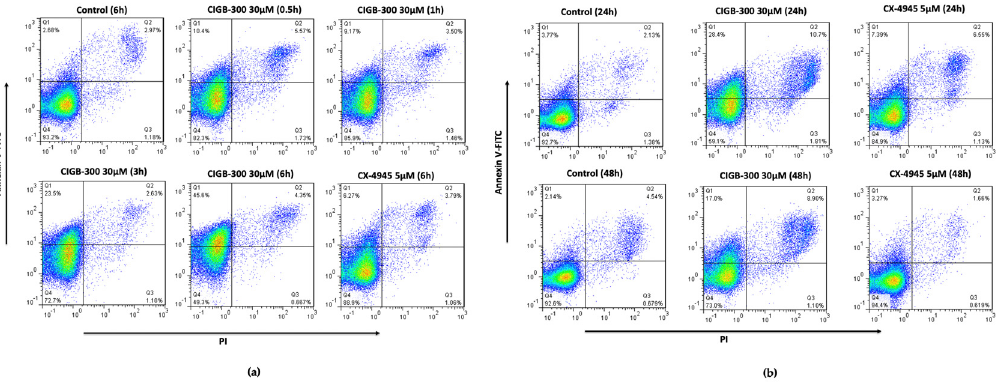
Figure 2 . Apoptotic profile of CIGB-300 and CX-4945 in NCI-H460 cell line at IC 50 values using a double staining with Annexin V-FITC and PI: ( a ) Short incubation times; ( b ) Later incubation